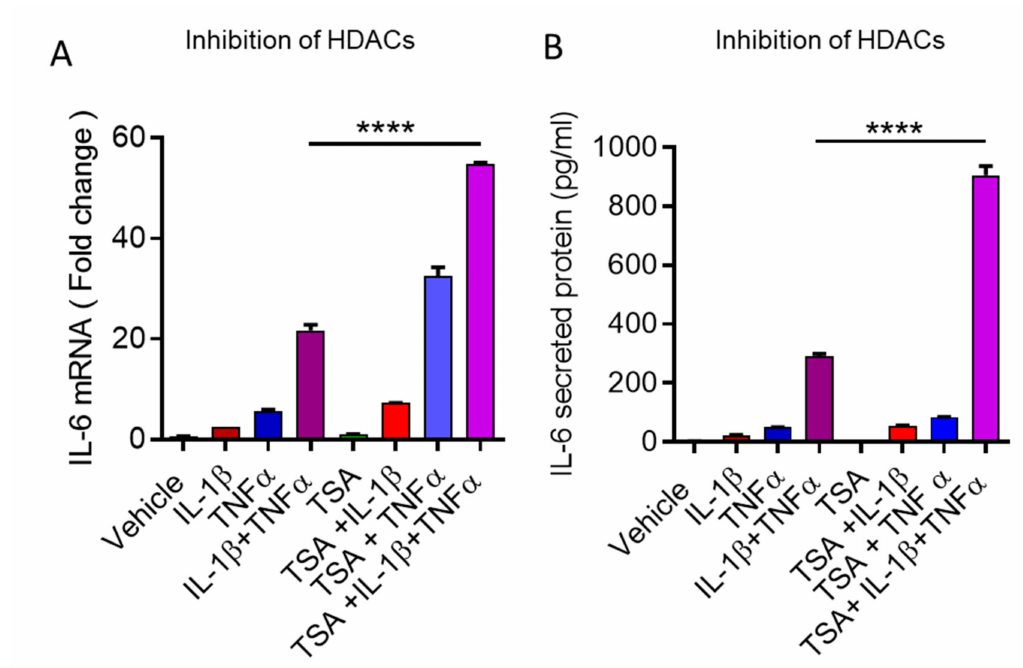
Figure 5. Trichostatin A (TSA) further enhances IL-1 β /TNF α expression of IL-6. Cells were treated with TSA (10 nM) for 4 h before stimulation with vehicle, IL-1 β , TNF α , or IL-1 β + TNF α for 24 h. ( A , B ) IL-6 mRNA and secreted protein were determined by qRT-PCR and ELISA, respectively. Data were expressed as mean ± SEM. **** p <